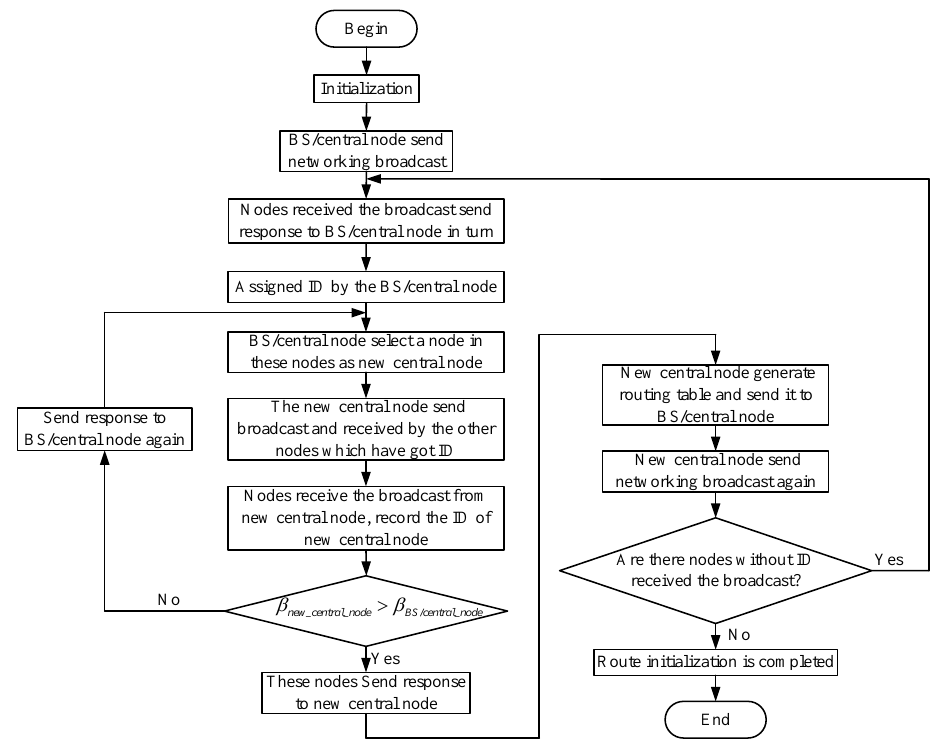
Figure 3. Flow chart of